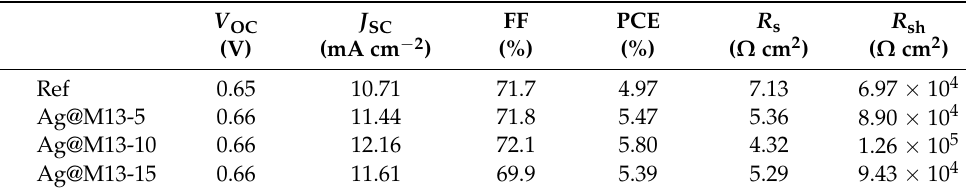
Figure 3. Photovoltaic properties of Ag@M13 enhanced FDSSCs: ( a ) comparison of J–V curves, ( b ) the IPCE spectra, ( c ) dark current profiles of FDSSCs as a function of Ag@M13, respectively, and ( d ) P max values over time as an outdoor test. Table 1. Photovoltaic properties of FDSSCs as a function of Ag@M13.